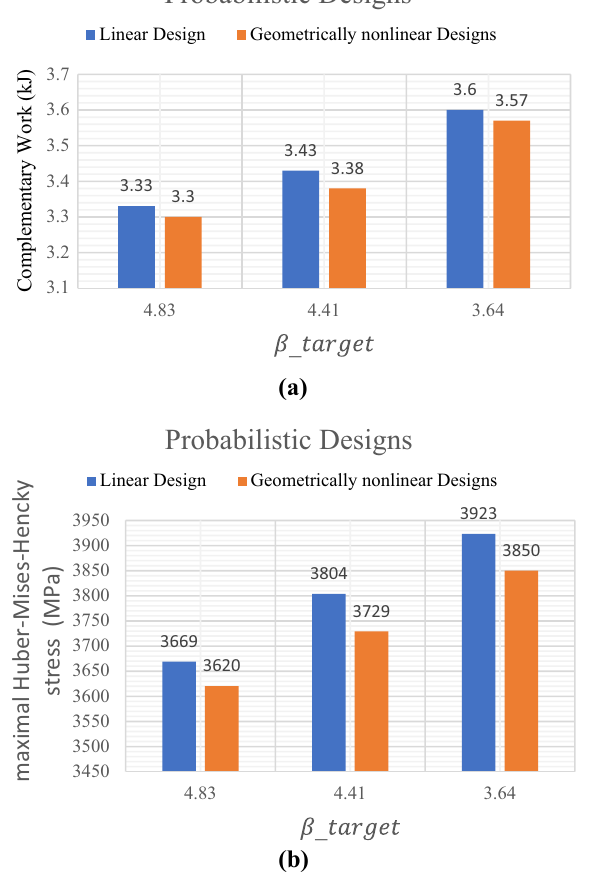
Figure 7. Comparison between linear and geometrically nonlinear probabilistic design by considering: ( a ) complementary work, ( b ) maximal Huber-Mises-Hencky